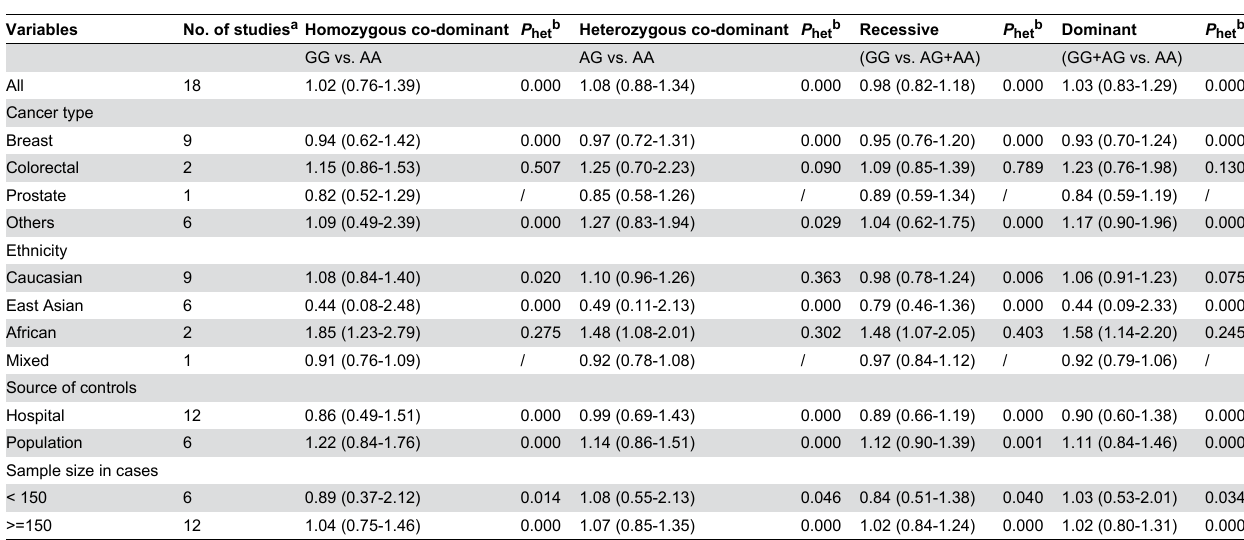
Table 3. Meta-analysis of the association between LEPR Q223R polymorphism and cancer